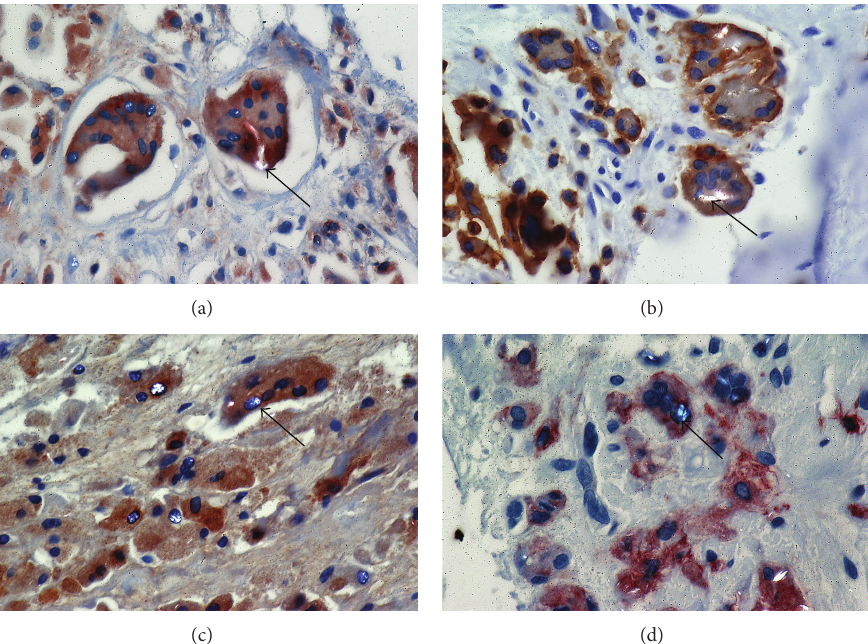
Figure 4: Expression of ITAM-associated molecules in PE-containing tissues from sites of aseptic loosening due to osteolysis. (a)